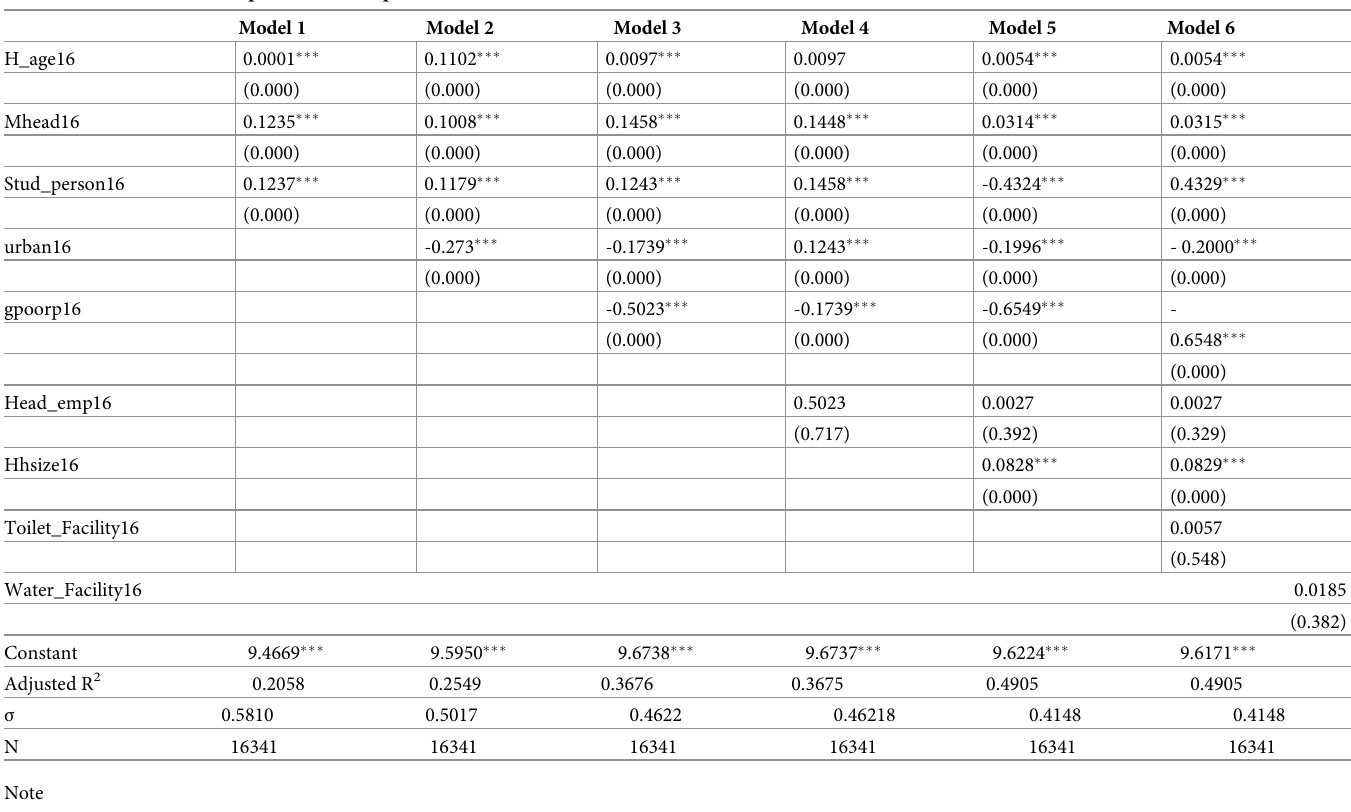
Table 10. Household consumption estimated parameter, Pakistan